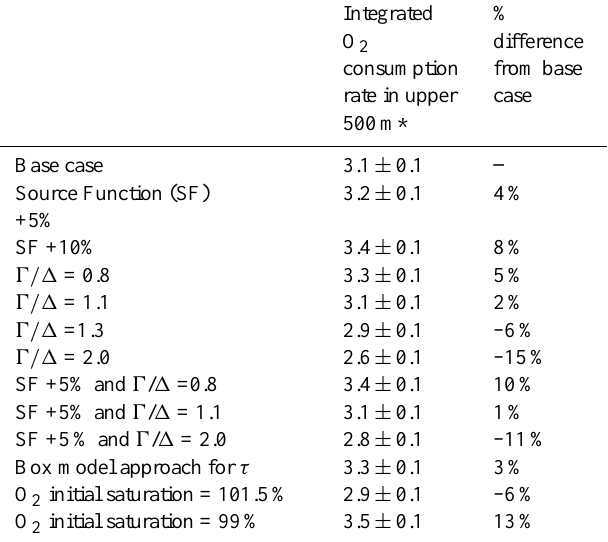
Table 2. Sensitivity study of depth-integrated O 2 consumption rate to reasonable choices of